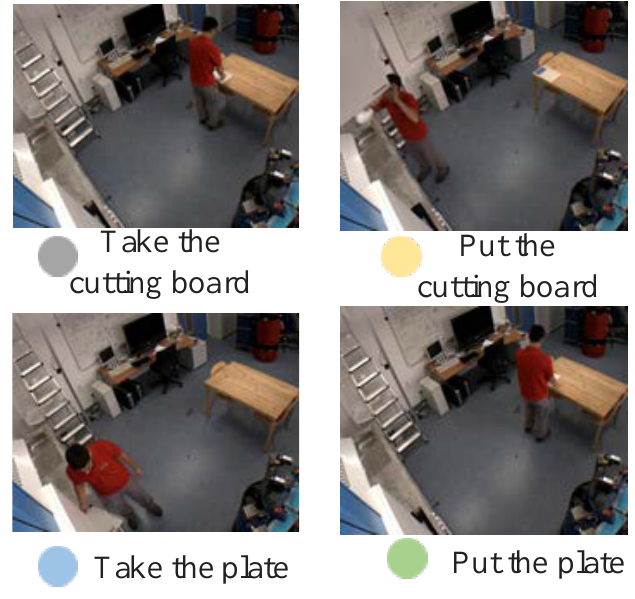
Figure 9. Sample Figure 9. Sample Dataset.